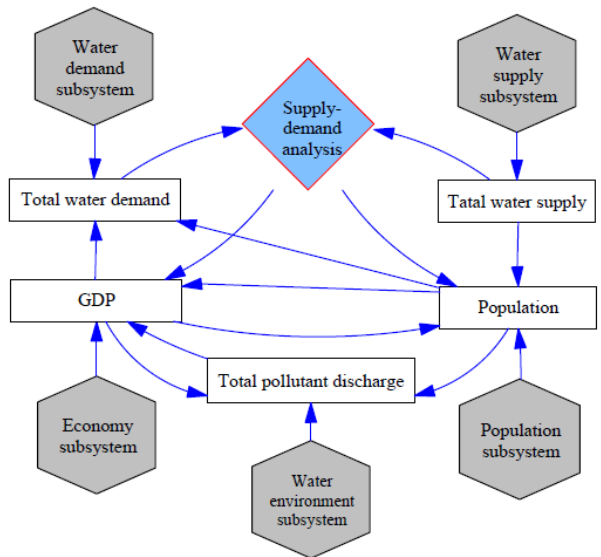
Figure 2. The framework of the water resource system.